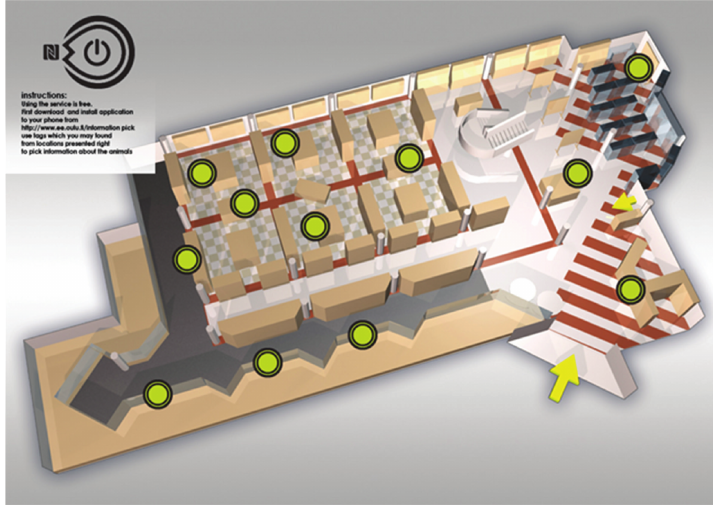
Figure 11: Collecting information in a museum: instructions at